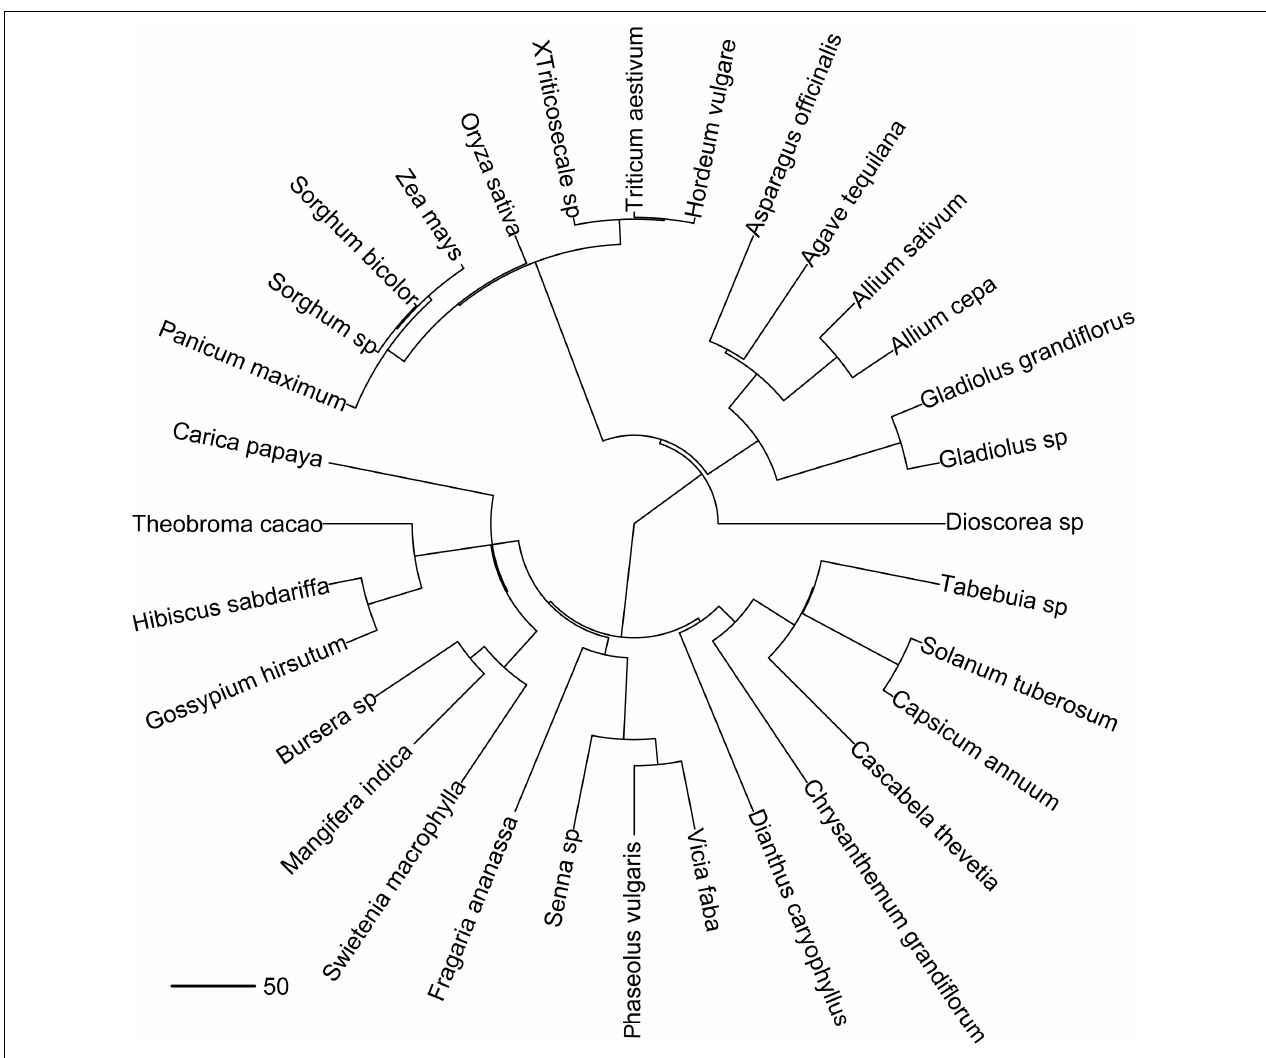
FIGURE 2 | Chronogram containing Monocots and Dicots species attacked by fusaria species. Branch lengths represent millions of years. Only host plants attacked by fusaria species with known identity were considered in the